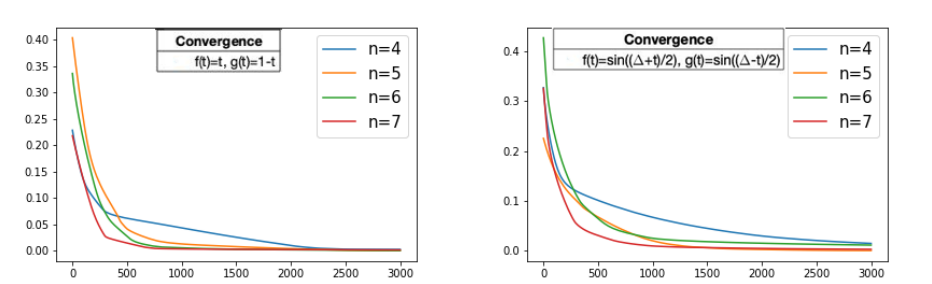
Figure 9. For different values of n , the history of the loss function, i.e., the mean absolute error values, through the training process on 3000 iterations while the fitting curves converges. ( Left ): Loss values of the fitting curve using f ( t ) = t , g ( t ) = 1 − t , t ∈ [ 0,1 ] . ( Right ): Loss values of the fitting curve using f ( t ) = sin (( ∆ + t ) /2 ) , g ( t ) = sin (( ∆ − t ) /2 ) , t ∈ [ − ∆ , ∆ ] . The x -axis represents the iteration of the training algorithm and the y -axis represents the mean absolute error